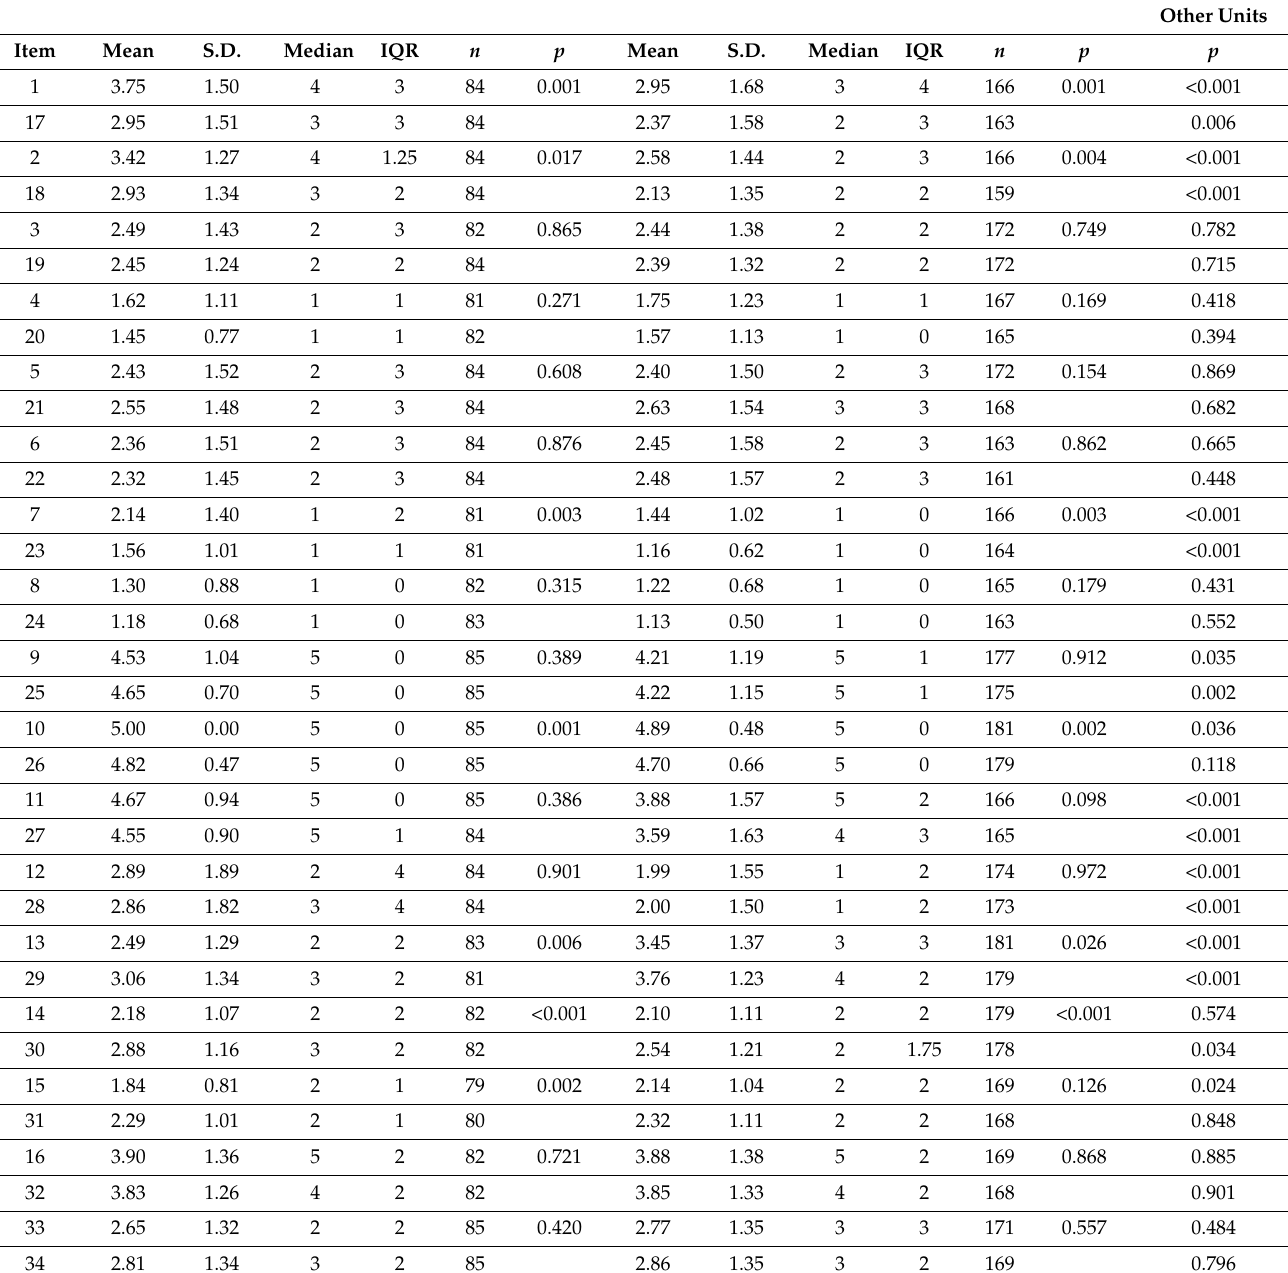
Table 2. Descriptive statistics and pairwise